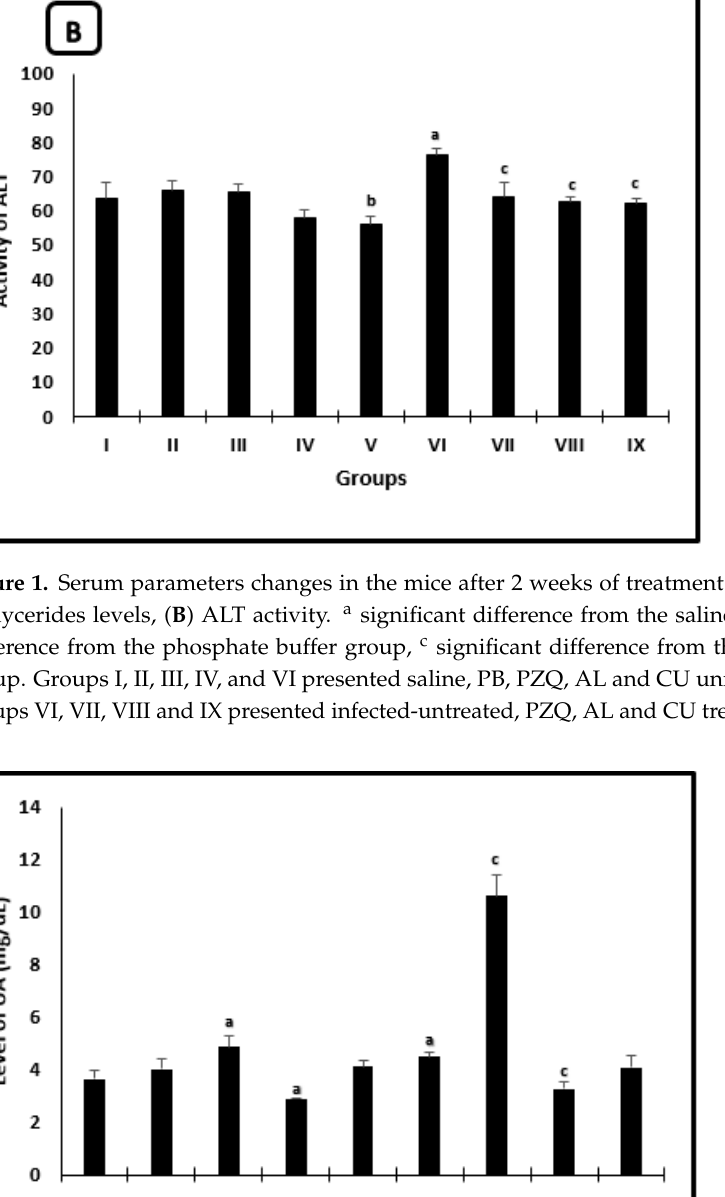
Figure 2. Serum uric acid level changes in mice after 2 weeks of treatment. a significant difference